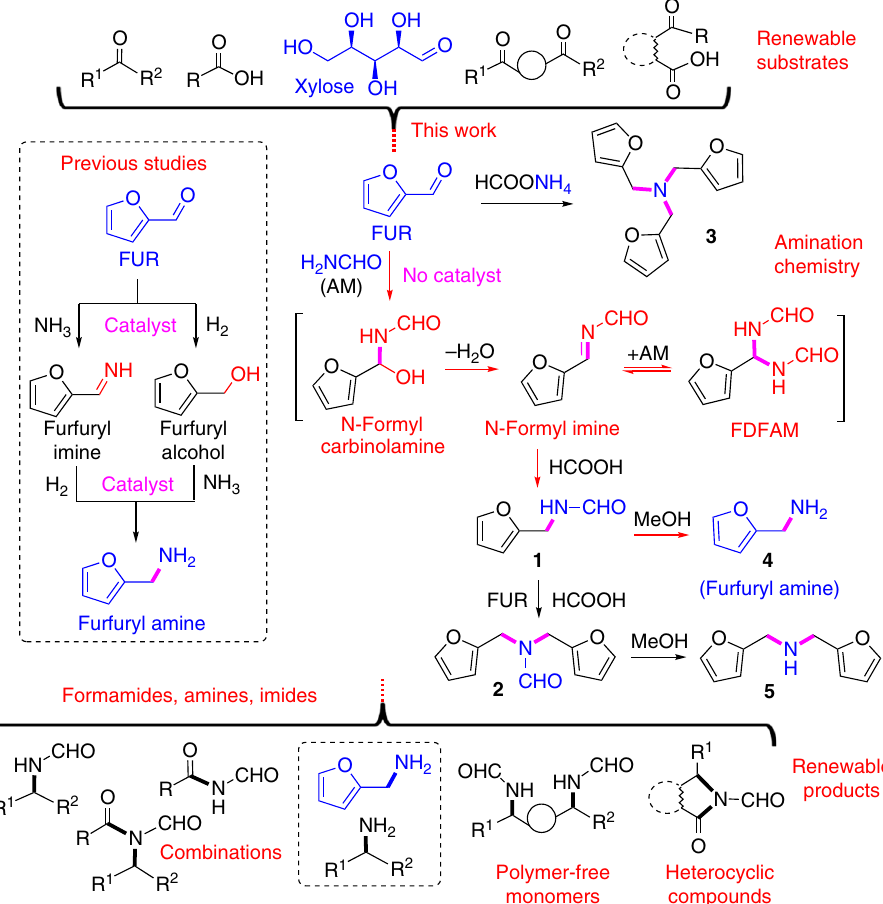
Fig. 1 Schematic of selective production of amines, formamides and N-formylimides. FUR: furfural, FDFAM: N , N ’ -(furan-2-ylmethylene)diformamide, 1 : N -(furan-2-ylmethyl)formamide, 2 : N , N -bis(furan-2-ylmethyl)formamide, 3 : tris(furan-2-ylmethyl)amine, 4 : furfurylamine, 5 :